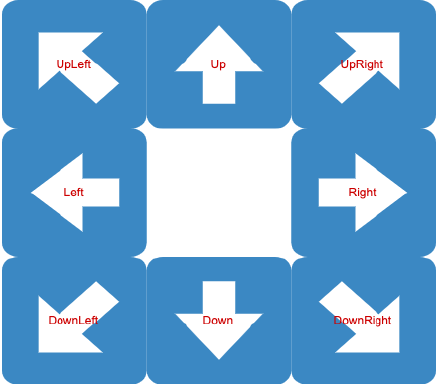
Figure 11. Classes used to classify arrow direction.